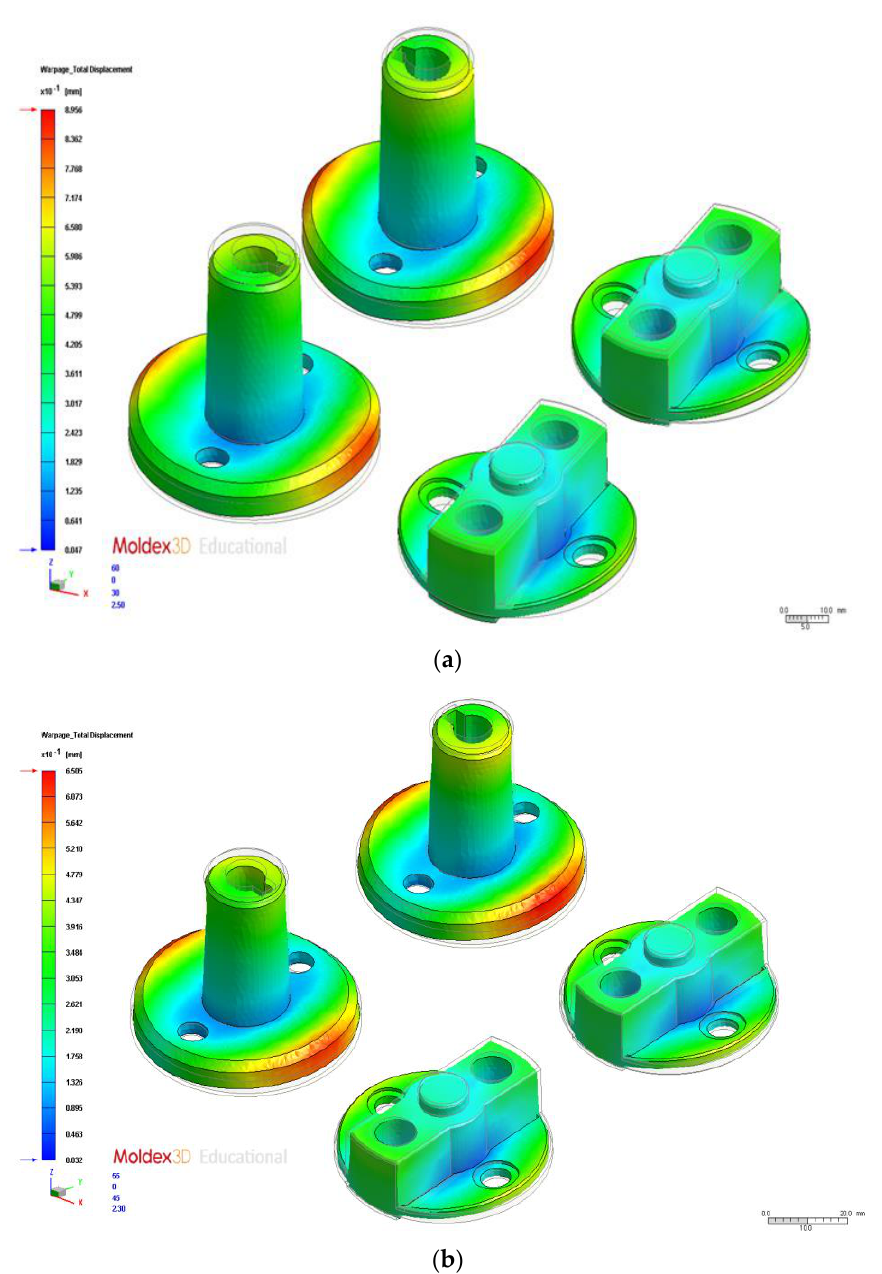
Figure 7. Total Warpage. ( a ) Original process. ( b )